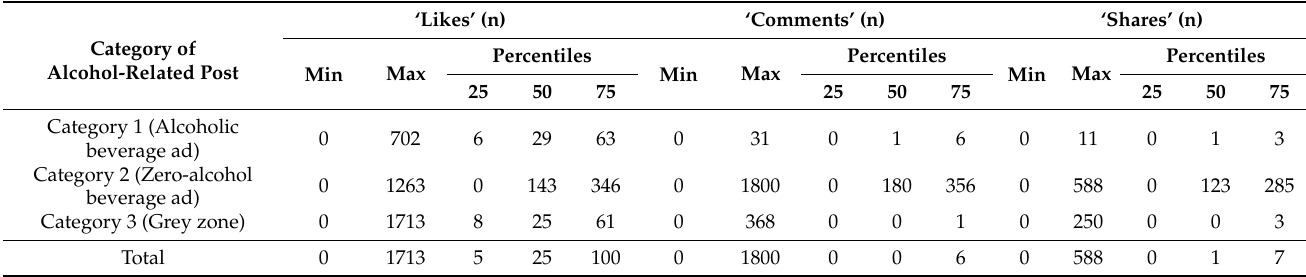
Table 5. Number of ‘likes, ‘comments’ and ‘shares’ per alcohol-related post category on Facebook within 60 days.